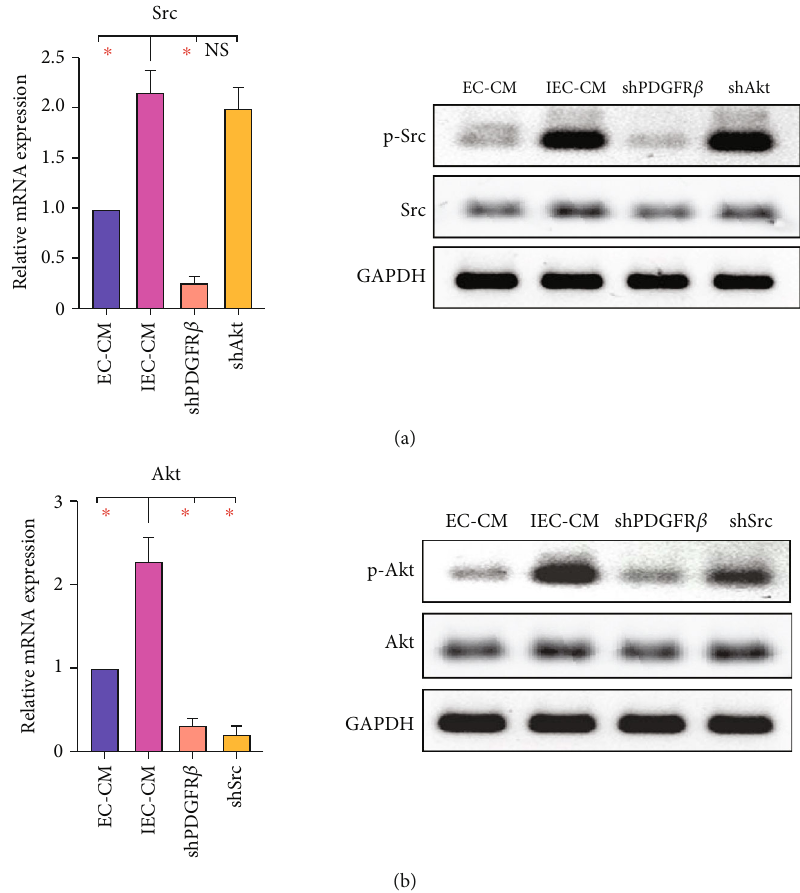
Figure 5: Src bridged connection between PDGFR β and Akt during ECs-induced MSCs migration. (a) Gene and protein expression of Src in migrating hBMSCs. (b) Gene and protein expression of Akt in migrating hBMSCs. EC-CM: conditioned media of ECs; IEC-CM: conditioned media of ECs in the context of in fl ammatory microenvironment; shPDGFR β : short hairpin RNA targeting pdgfrb ; shSrc: shRNA targeting src ; shAkt: shRNA targeting akt . ∗ P < 0 : 05